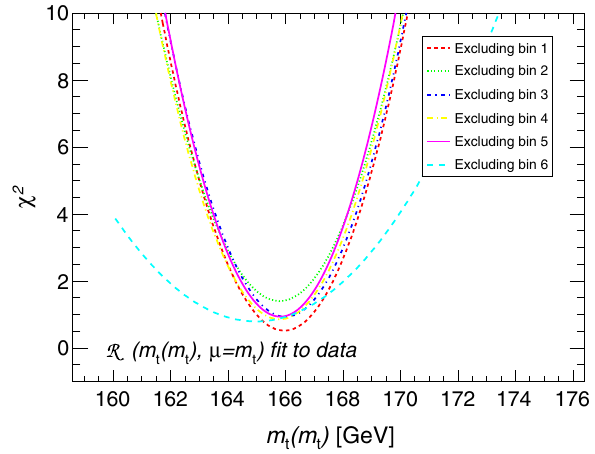
Fig. 4 The χ 2 as a function of m t ( m t ) for different choices of the excluded bin. The bin boundaries for the six bins are given in Table